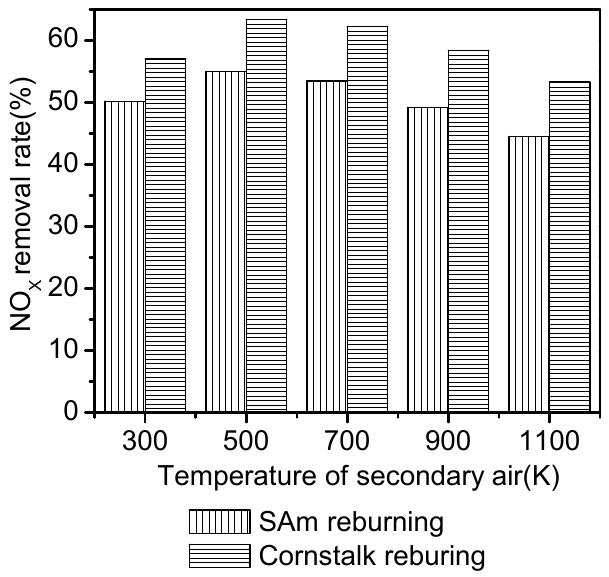
Figure 12. NO x removal rate at different temperatures of the secondary